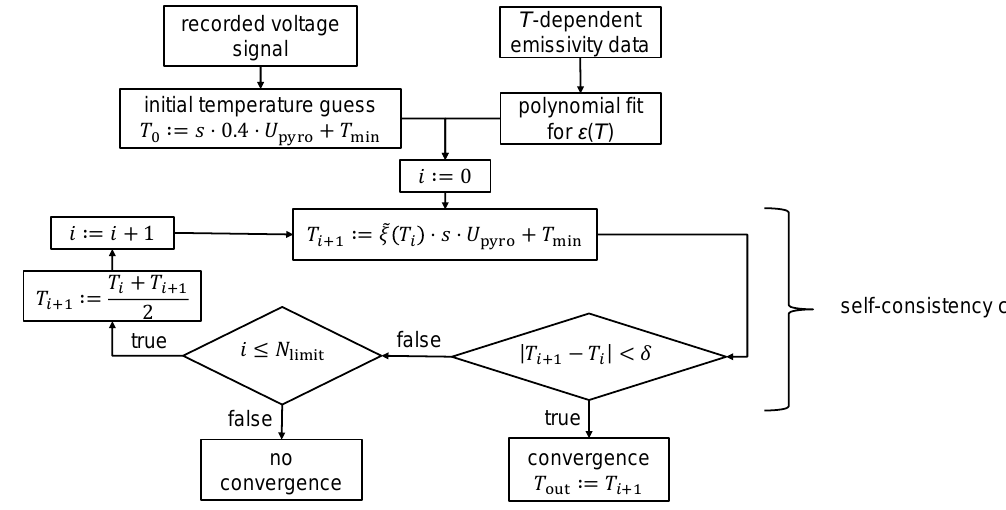
Figure 6. Flow chart of self-consistent temperature calculations.